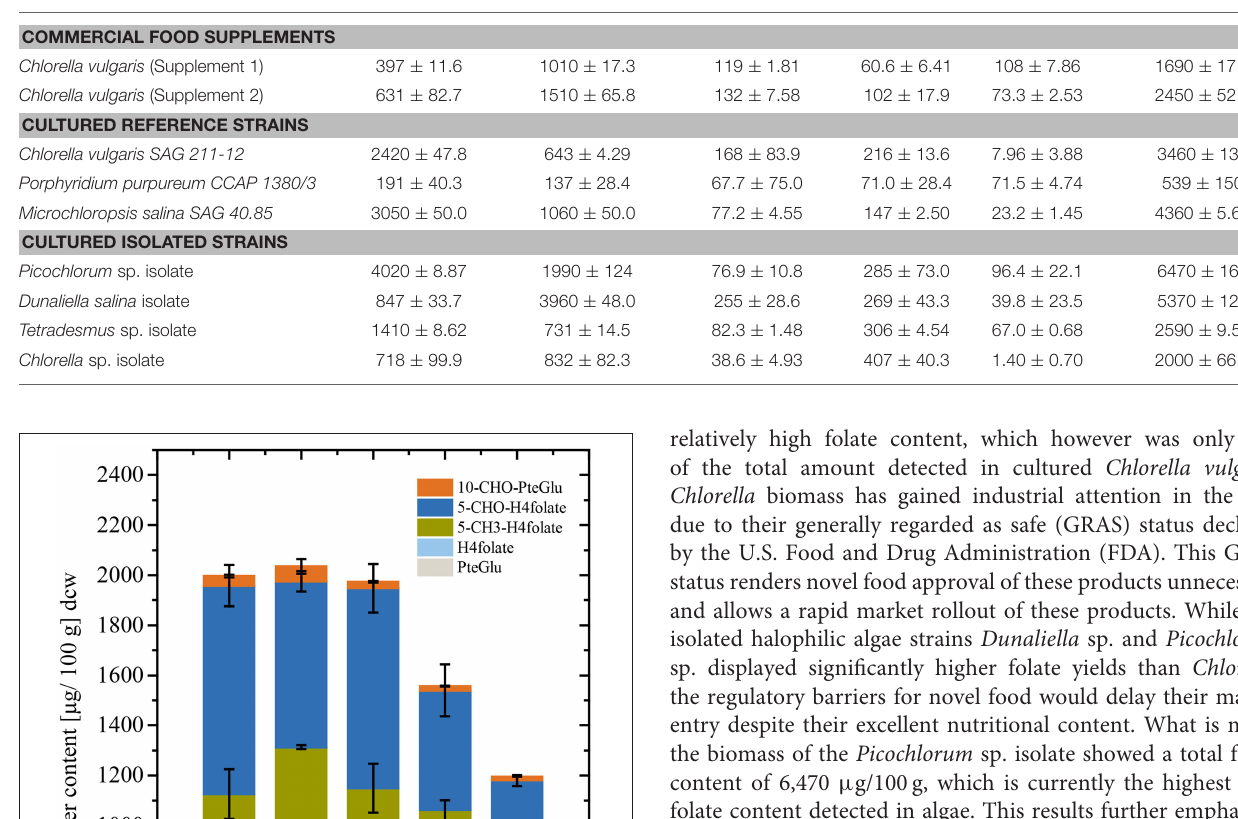
TABLE 3 | The folate content and vitamer distribution of selected microalgae strains, calculated as PteGlu in [ µ g/100g]. Genus; species; strain